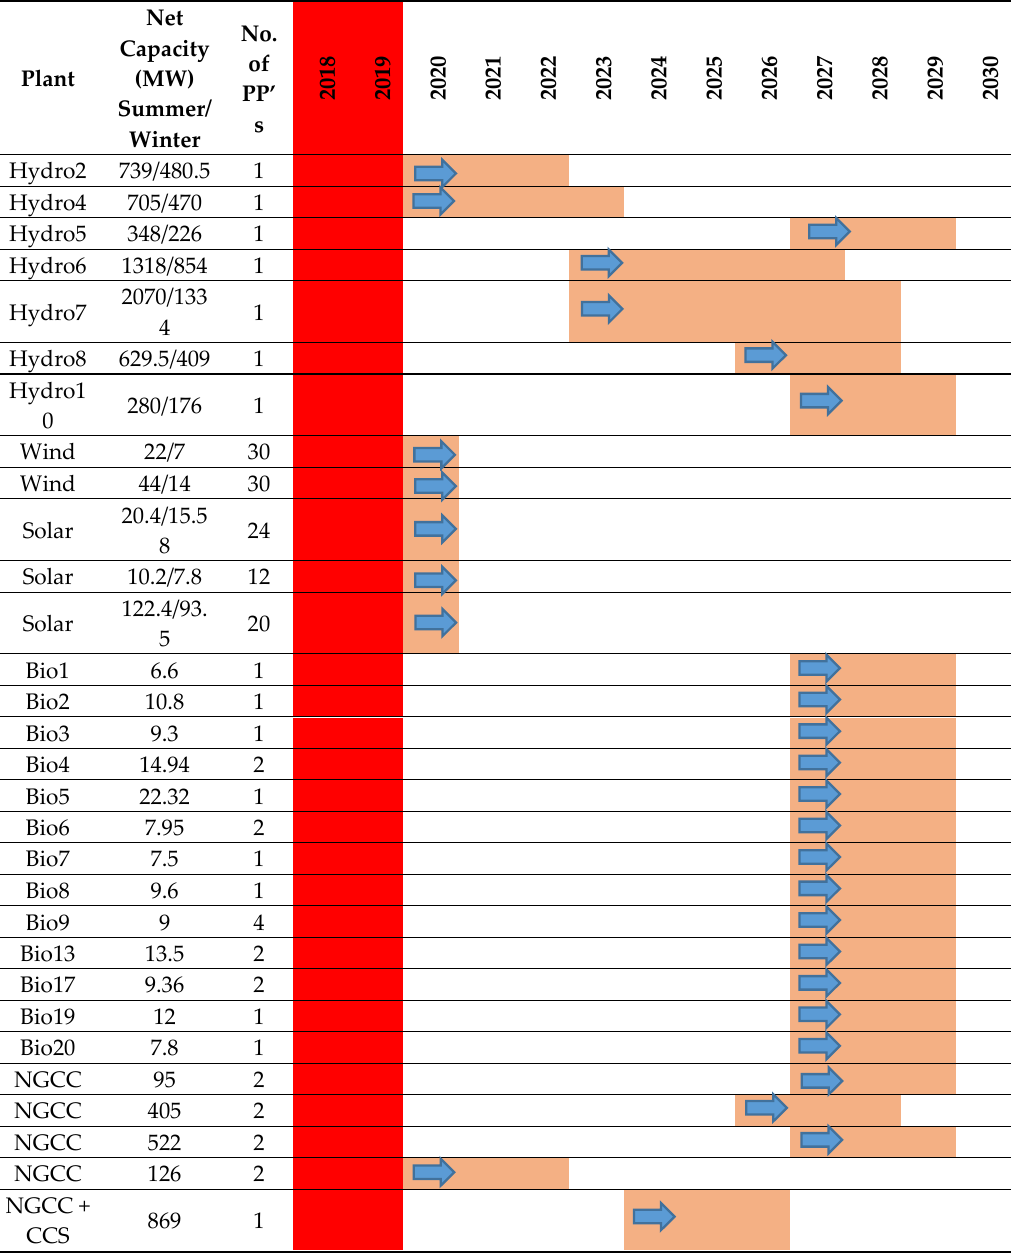
Table A10. Details of the Plants Installation under Capacity Expansion: Normal GDP Fuel Balancing (5–50% Mitigation).